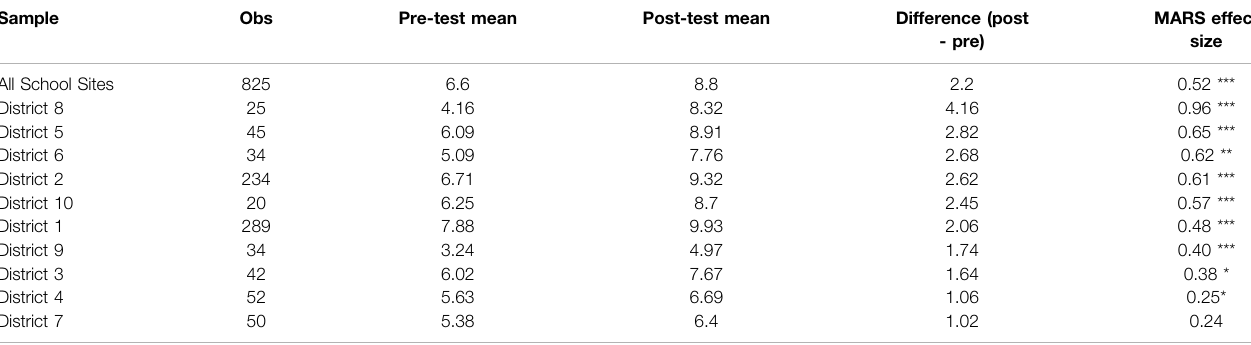
TABLE 3 | Pre/post design results by district, listed by effect size. Sample Obs Pre-test